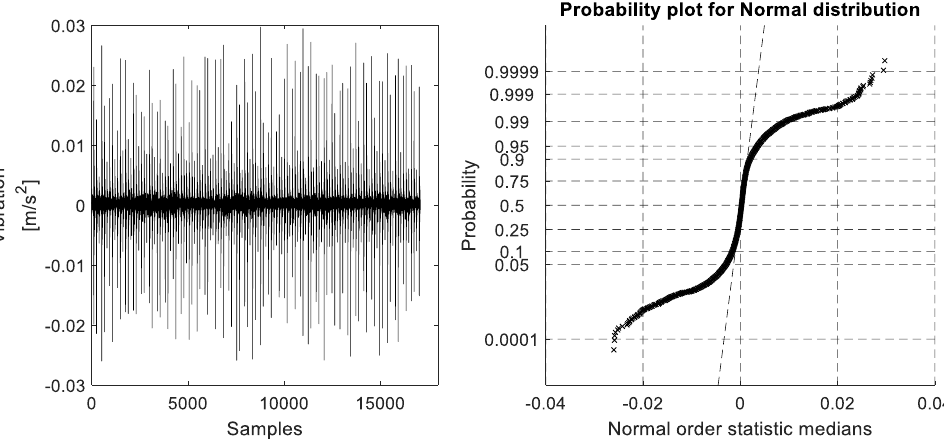
Figure 11. Raw vibration data signal from accelerometer #2 and its ProbPlot in outer-race fault (ORF) case under constant speed environment.